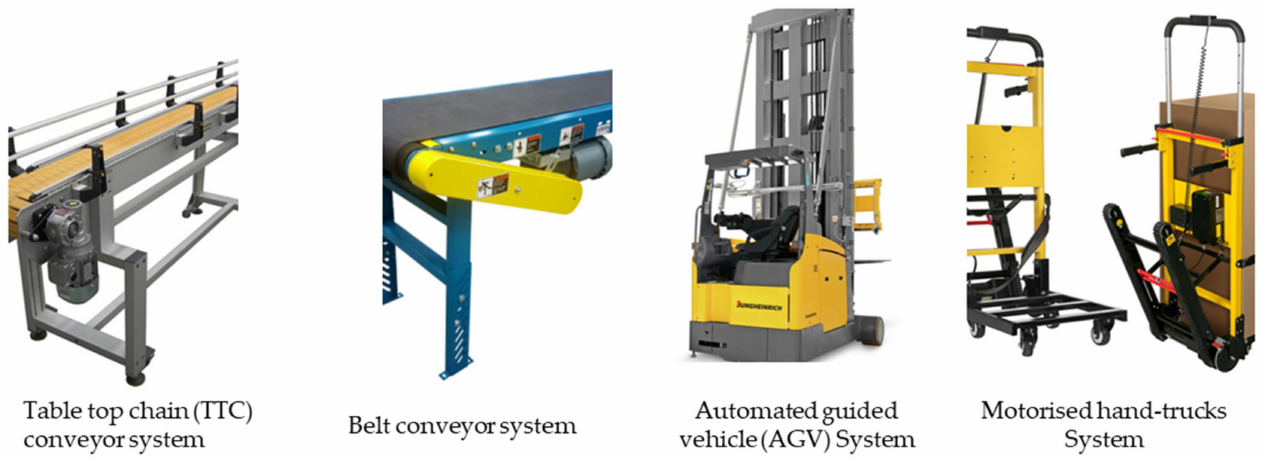
Figure 2. Proposed concepts for the roof tile transportation